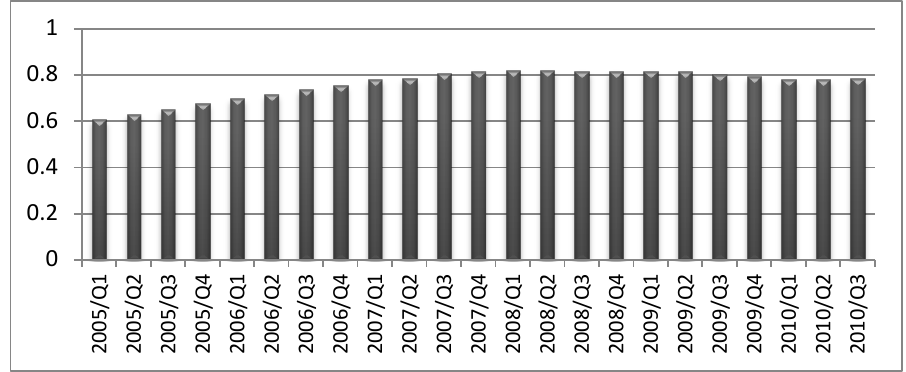
FIGURE 1: Household debt to disposable income, 2005 – 2010 Source: Authors’ compilation based on statistical output from Stata version